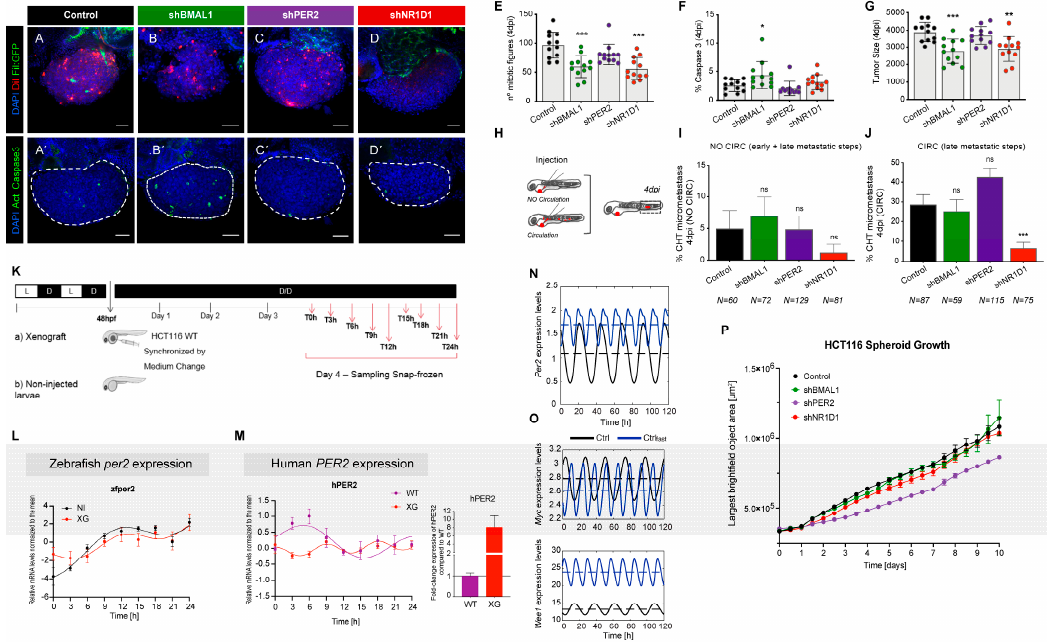
Figure 4. ( A – D )—Representative confocal images of zebrafish larvae xenografts. Human CRC HCT116 control and KD cells ( shPER2 , shBMAL1 and shNR1D1 ) were labelled with DiI dye (red) and injected into the PVS of 2dpf Tg(Fli:eGFP) zebrafish ( n = 12). At 4dpi mitotic figures ( E ), % of apoptosis ( F -Activated caspase 3), tumour size ( G - number of tumour cells) and metastatic potential ( H – J ) were quantified. Metastatic potential was quantified by injecting cells into the Perivitelline Space (PVS) only, with no cells in circulation ( I ) and cells injected directly into circulation ( J ). All images show xenografts anterior to the left, posterior to the right, dorsal up and ventral down. Each dot represents one xenograft. Results are from one single independent experiment. Statistical analysis was performed using Mann–Whitney test (ns or no asterisk p > 0.05, * p ≤ 0.05, ** p ≤ 0.01, *** p ≤ 0.001). Error bars: mean ± SEM. Scale bars: 50 µ m. ( K ) Overview of the time-course for the in vivo study. HCT116 cells were injected into zebrafish larvae at 48h post-fertilisation (48 hpf). After 3 days, xenograft larvae (XG) were collected every 3h for the course of 24h during dark / dark conditions. Non-injected zebrafish larvae were used as controls (NI), n = 45 larvae / time-point. Time-course mRNA expression levels compared to the mean for: ( L ) zebrafish per2 gene in non-injected zebrafish larvae (black line and dots) and zebrafish xenografts injected with HCT116 cells (red line and dots), ( M ) human PER2 gene in zebrafish xenografts injected with HCT116 cells (red line and dots) and in human in HCT116 WT cells (purple line and dots). The average h PER2 expression between XG and HCT116 WT cells is depicted as a bar plot. Cosinor fitting curves were applied for the determination of oscillation parameters (Table S5, Table S7 for list of primers for RT-qPCR, no asterisk p > 0.05). ( N–O ) Shown are the in silico expression profiles for ( N ) PER2 ( O ) MYC and WEE1 in Ctrl (T = 23.7 h, black) and Ctrlfast conditions (T = 13.8 h, blue). ( P ) HCT116 spheroid growth rates over time upon core-clock gene knockdown ( shBMAL1 , shPER2 and shNR1D1 ) compared to the control. n = 5, mean ± SEM, p < 0.05 for shPER2 compared to control using two-way ANOVA and corrected for multiple testing using Benjamini and Yekutieli